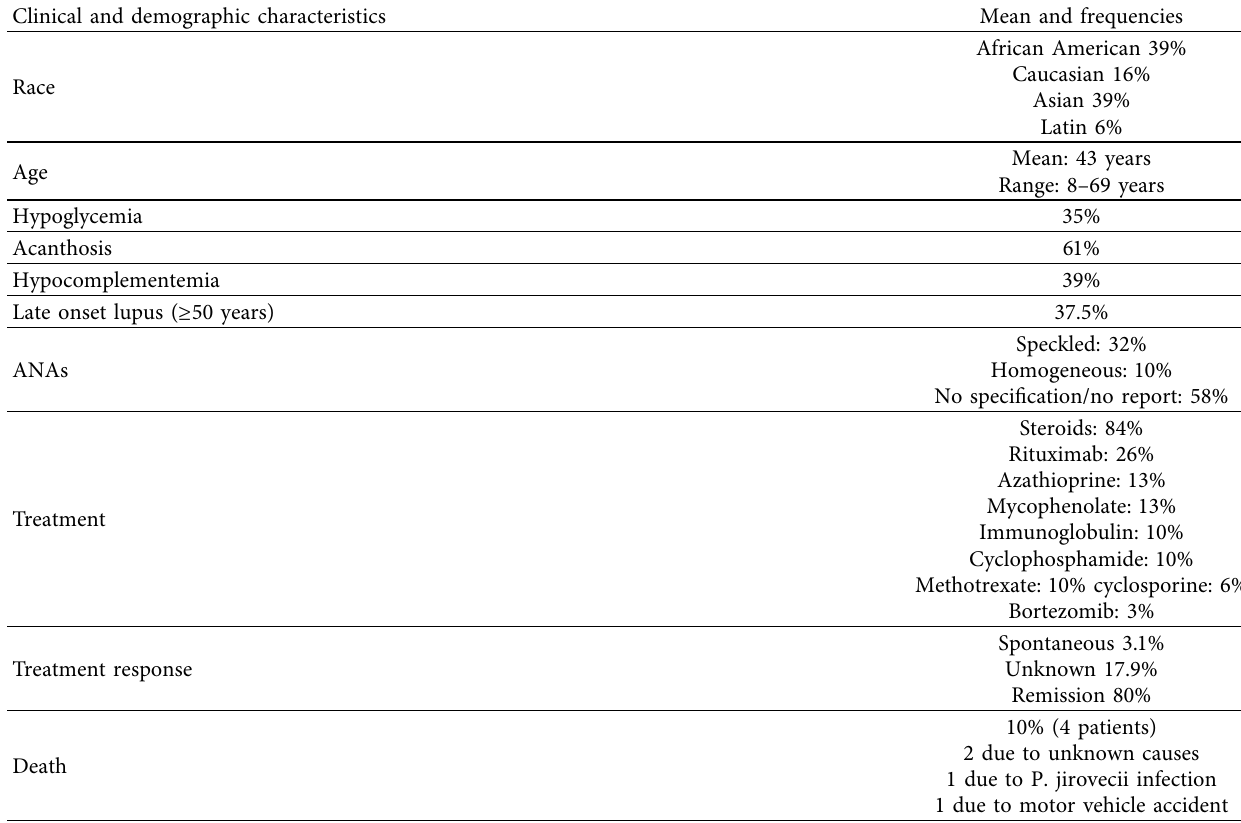
Table 3: SLE-associated TBIRS patients’